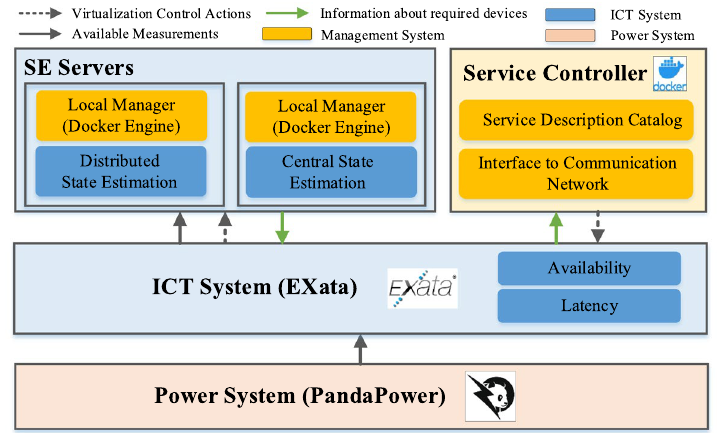
Fig. 3 Overview of connected tools and software in the test